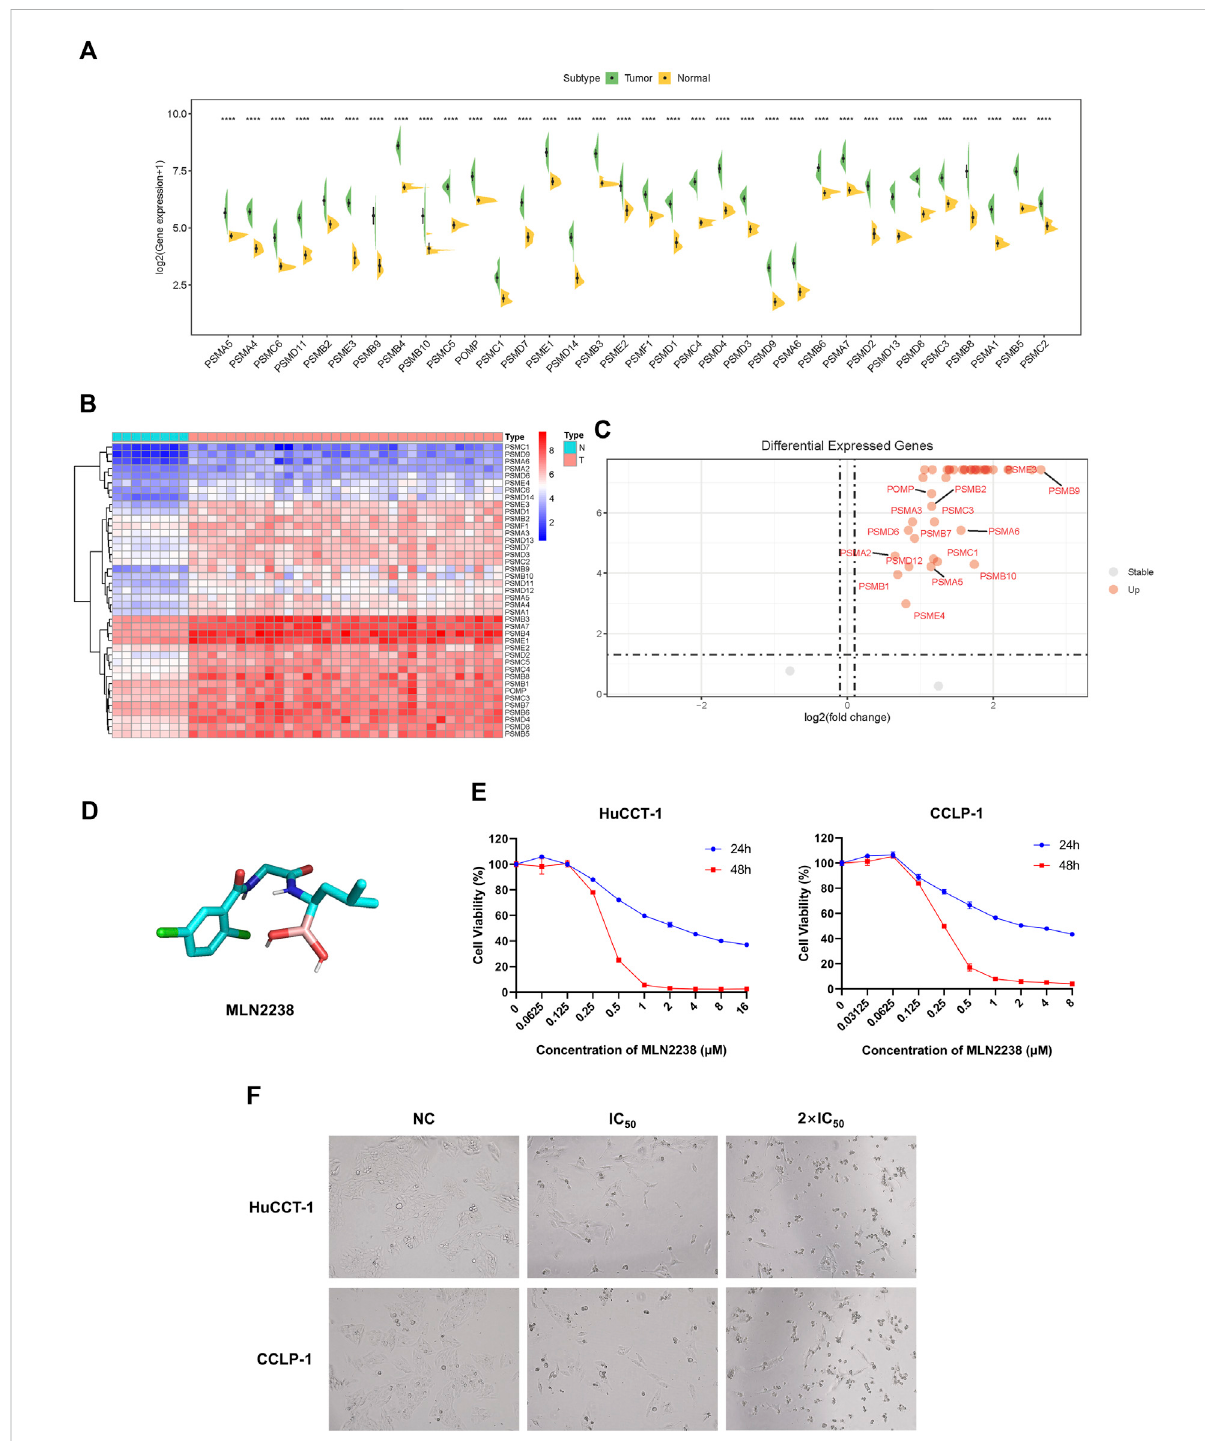
FIGURE 3 Anti-cancereffectofMLN2238oniCCAcells. (A) Theexpressionlevelsofproteasome-relatedgenesbetweennormalandiCCAtissues. (B) The heatmap showing the proteasome-related genes expression levels in normal and tumor samples. (C) The Volcano Plot displaying the distribution of proteasome-related genes between normal tissues and malignant tumor lesions. (D) Chemical structures of MLN2238. (E) The IC50 values of MLN2238 in iCCA cells (HuCCT-1 and CCLP-1). (F) Morphological alteration of HuCCT-1 and CCLP-1 cells after MLN2238 treatment, which observed by microscope (×100 magni fi